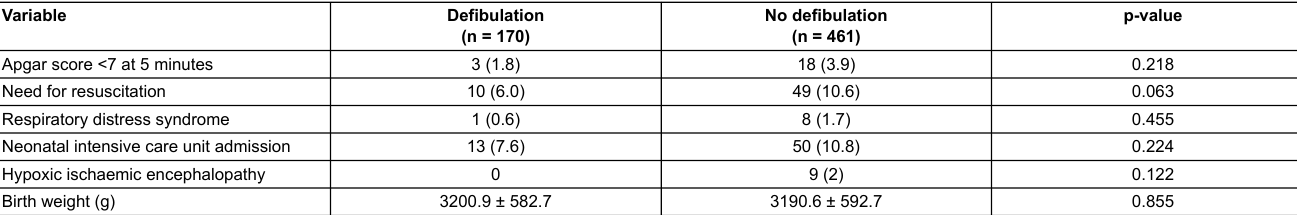
Table 3: Description and comparison of the neonatal outcomes of the defibulated patients and the control group.